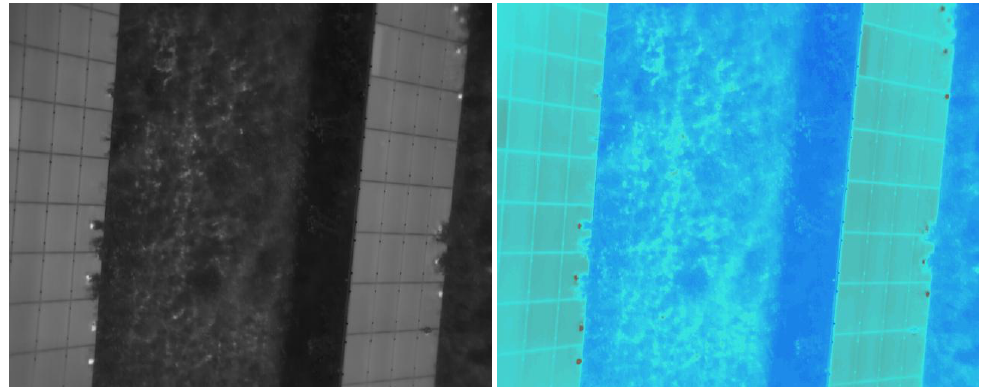
Figure 14. The same thermogram converted to the grayscale image with adaptive temperature range (1) on the left and to the Arctic palette image with uniform temperature scaling (2) on the right .